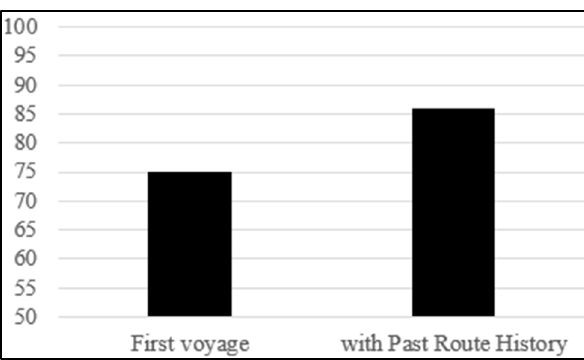
Figure 9. Accuracy Variations in the Forecast due to time Propagation.